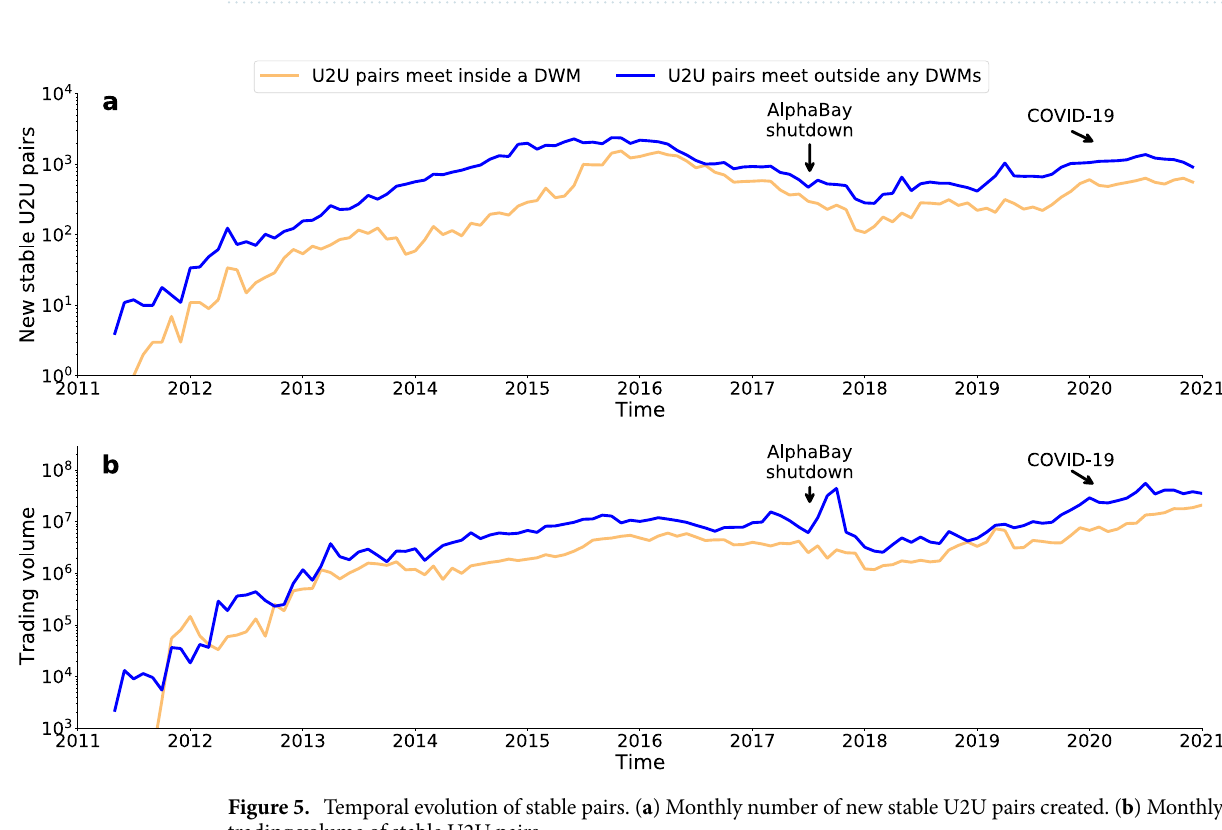
Overall, stable U2U pairs have shown resilience to the systemic stress caused by COVID-19, suggesting, once again, that these trading relationships are fundamentally independent from the underlying DWMs.